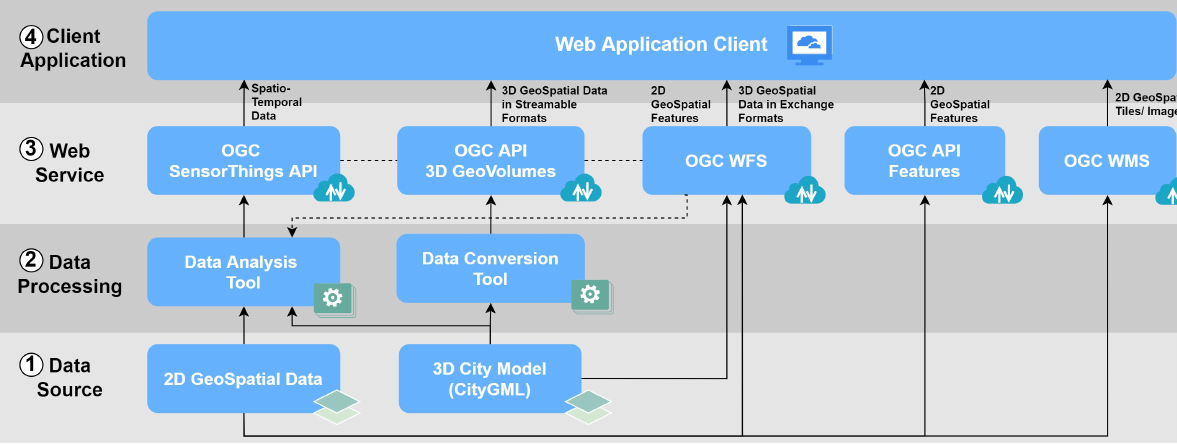
Figure 4. The conceptual SDI for the UDT application in the building energy